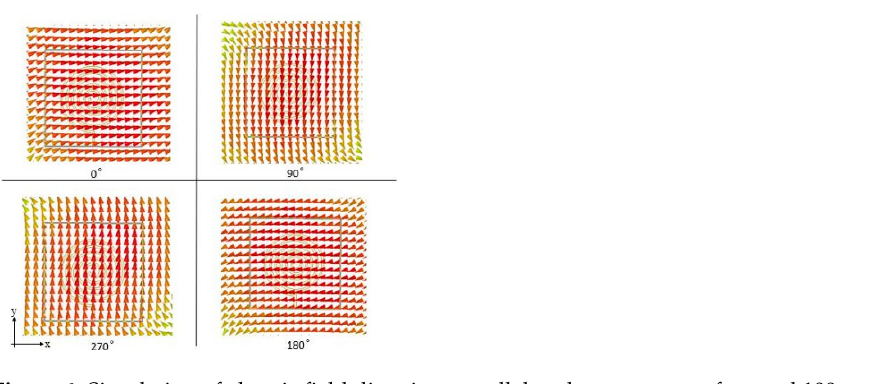
Figure 6. Simulation of electric field direction, parallel to the antenna surface and 100 mm from the antenna, at phases 0°, 90°, 180°, and 270°.